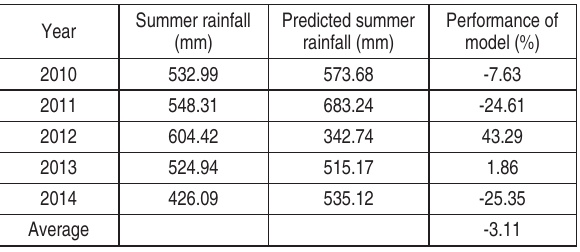
Table 7. Out-of-sample